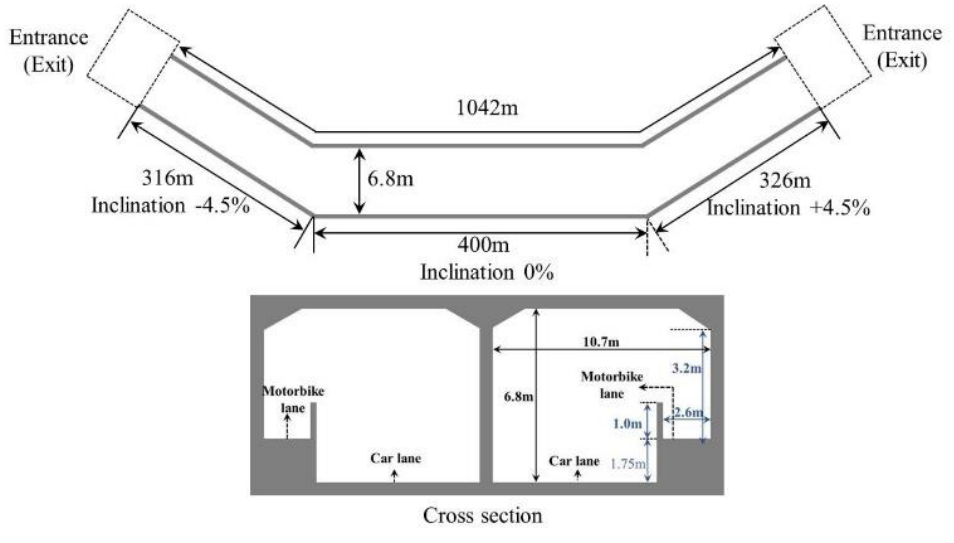
Figure 2. Cross-Harbor Tunnel geometry.